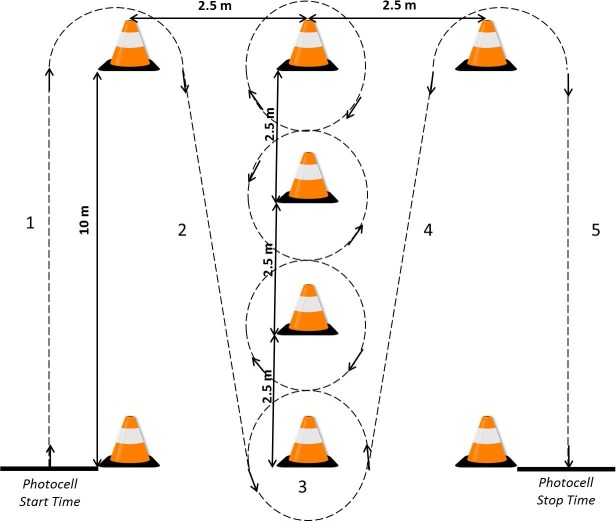
Schematic representation of Illinois Agility Test.